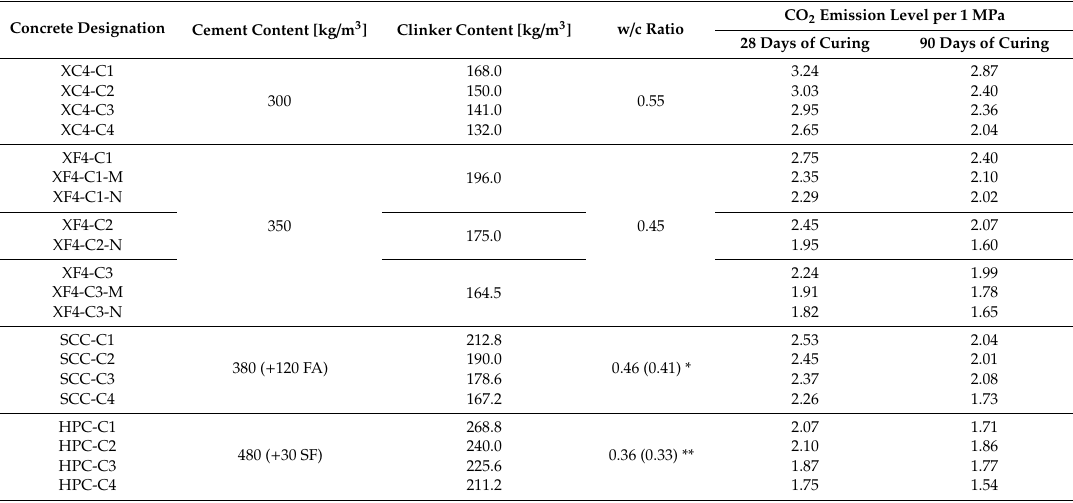
Table 15. The emissivity of concretes calculated per